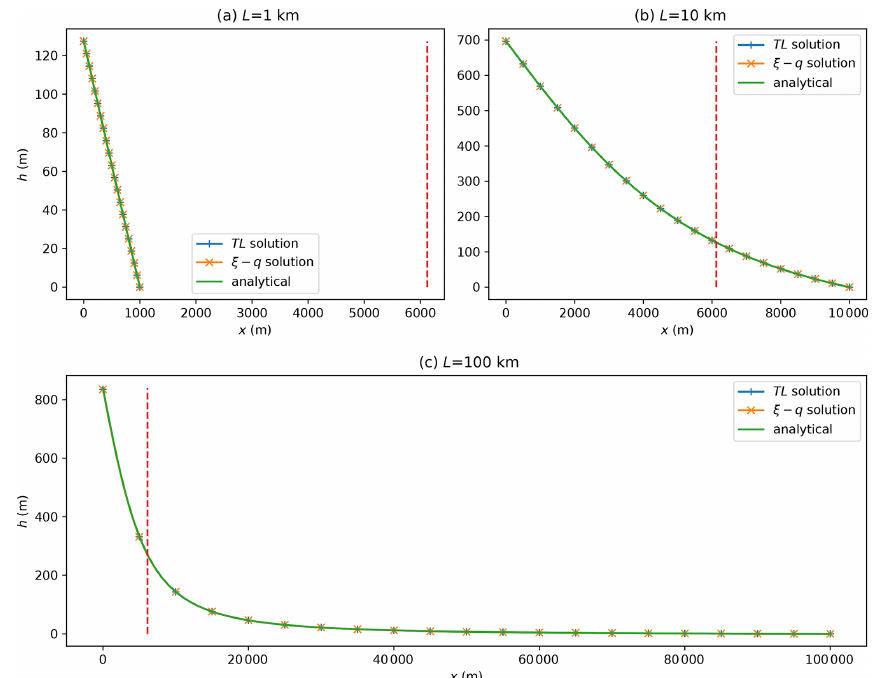
Figure 3. Steady-state depositional profiles obtained by solving both the ξ – q and TL equations using three different values for the ratio r = kL p /A 0 ; all other parameters are identical to values used for the profile in Fig. 2. The dashed line represents the position of the length scale L 0 = ( A 0 /k ) 1 /p . Three curves are shown, corresponding to the analytical solution as described by Eqs. (15) or (16) and the two solutions obtained using the numerical methods described above.